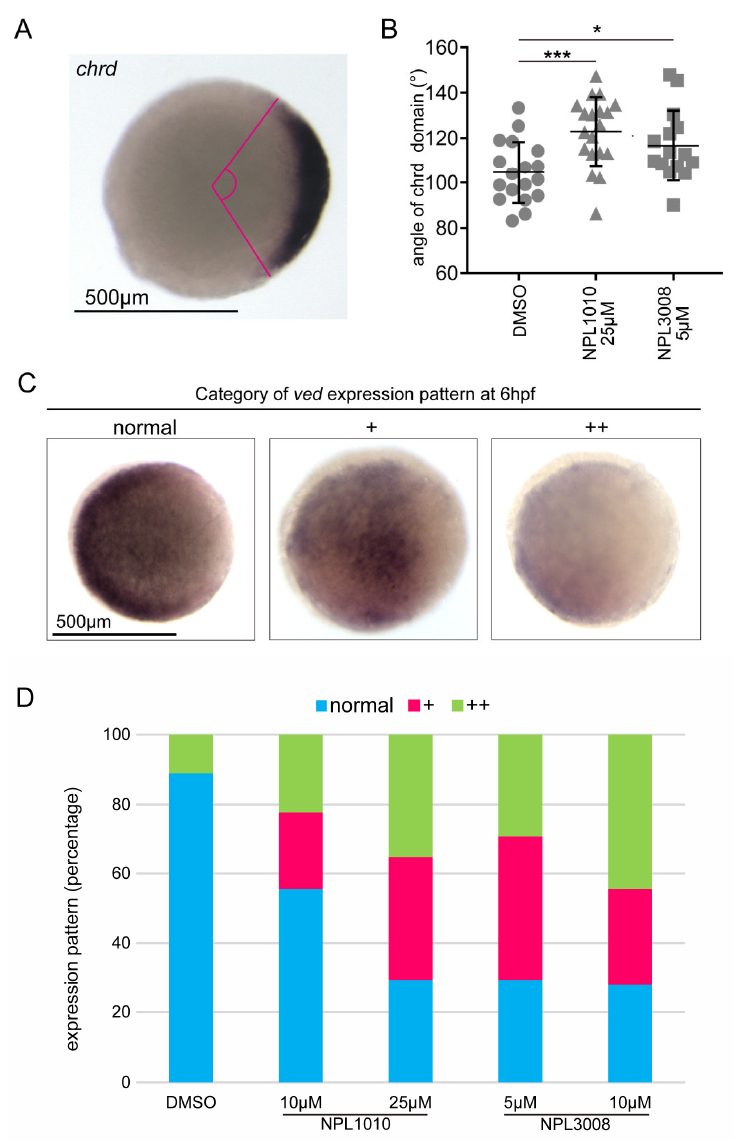
Figure 2. NPL1010 and NPL3008 affect the expression of genes involved in D–V patterning. ( A ) Method used to measure the angle of the chrd expression domain with representative chrd expression shown in the photographs. The central angle (shown by the magenta line) of the chrd expression domain was measured. Animal pole view, dorsal to the right. Scale bar, 500 µ m. ( B ) The statistical analysis of angles of the chrd expression domain in NPL1010- or NPL3008-treated embryos. Data are presented as the means ± s.d., with individual data shown. *: p < 0.05, ***: p < 0.001 (Dunnett’s test). ( C ) Classification of the ved expression pattern, normal, slight reduction/mild phenotype (+), and strong reduction/severe phenotype (++), at 6 hpf with representative expression patterns shown in the photographs. Animal pole view, ventral to the left. Scale bar, 500 µ m. ( D ) Proportion of NPL1010- or NPL3008-treated embryos displaying ved expression patterns ( n =